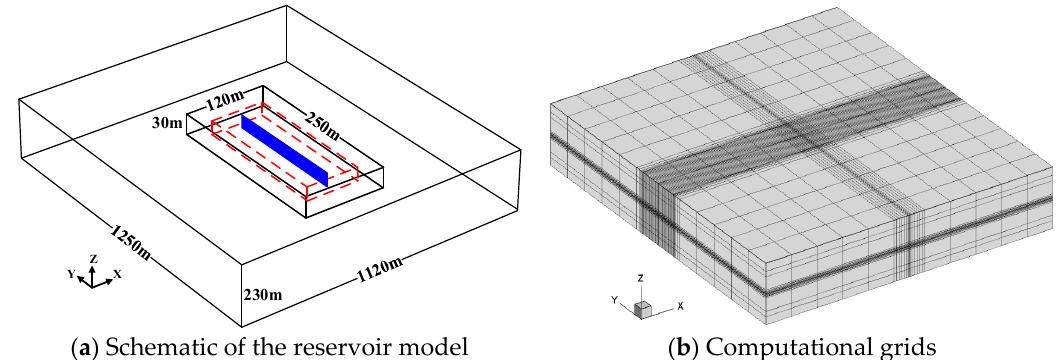
Figure 11. Schematic of the reservoir model and its computational grids. Table 2. Parameters of the shale reservoir for applications and discussions.